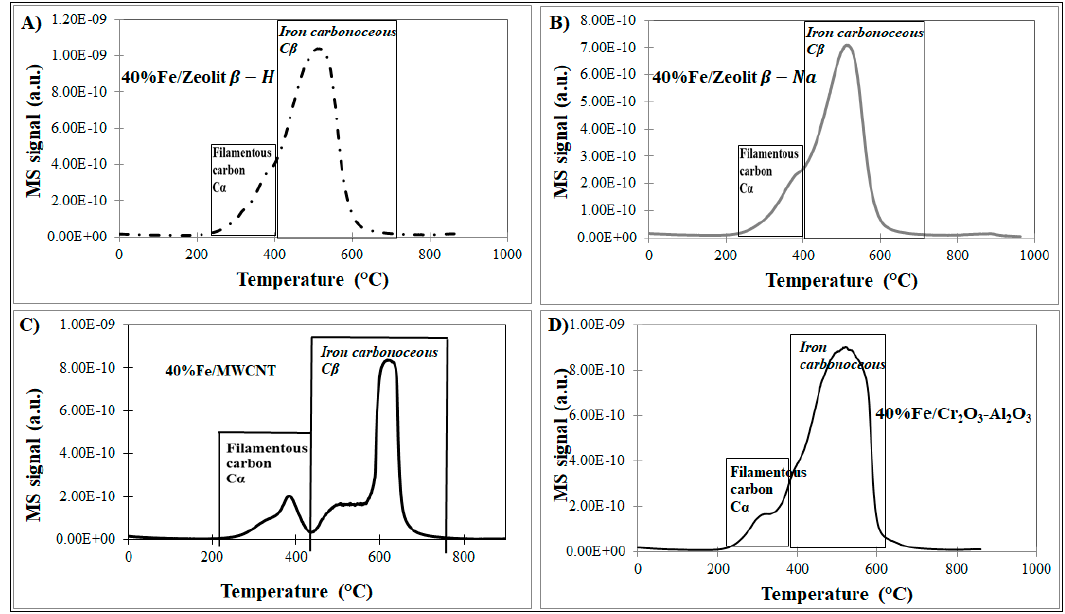
Figure 3. The mass spectrum of the gaseous decomposition products in ( A ) Fe/Zeolite β –H; ( B ) Figure3. Themassspectrumofthegaseousdecompositionproductsin( A )Fe / Zeolite β –H;( B )Fe / Zeolite Fe/Zeolite β –Na; ( C ) Fe/MWCNT; ( D ) Fe/Al 2 O 3 -Cr 2 O 3 . β –Na; ( C ) Fe / MWCNT; ( D ) Fe / Al 2 O 3 -Cr 2 O 3